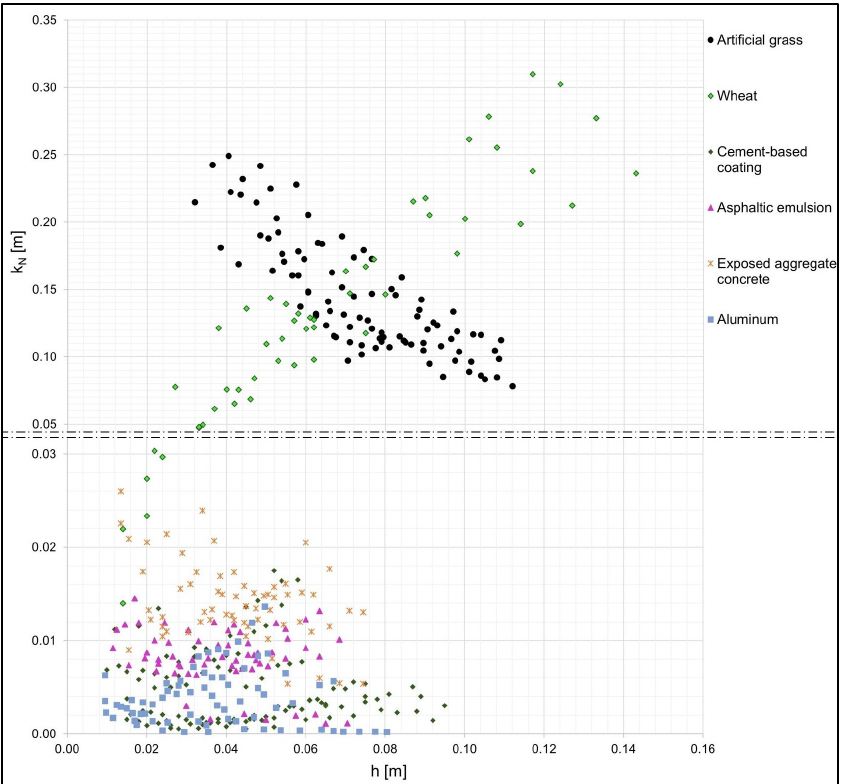
Figure 3. Relationship between water depth h and equivalent sand–grain roughness k N for different bed roughnesses. Ordinate was split to better show data points with low k N . According to Augustijn et al. [16], Gualtieri et al. [26] and Huthoff et al. [31],